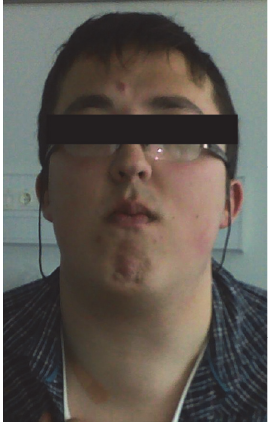
Figure 1: Patient photograph showing diffusely enlarged thyroid gland (frontal view).